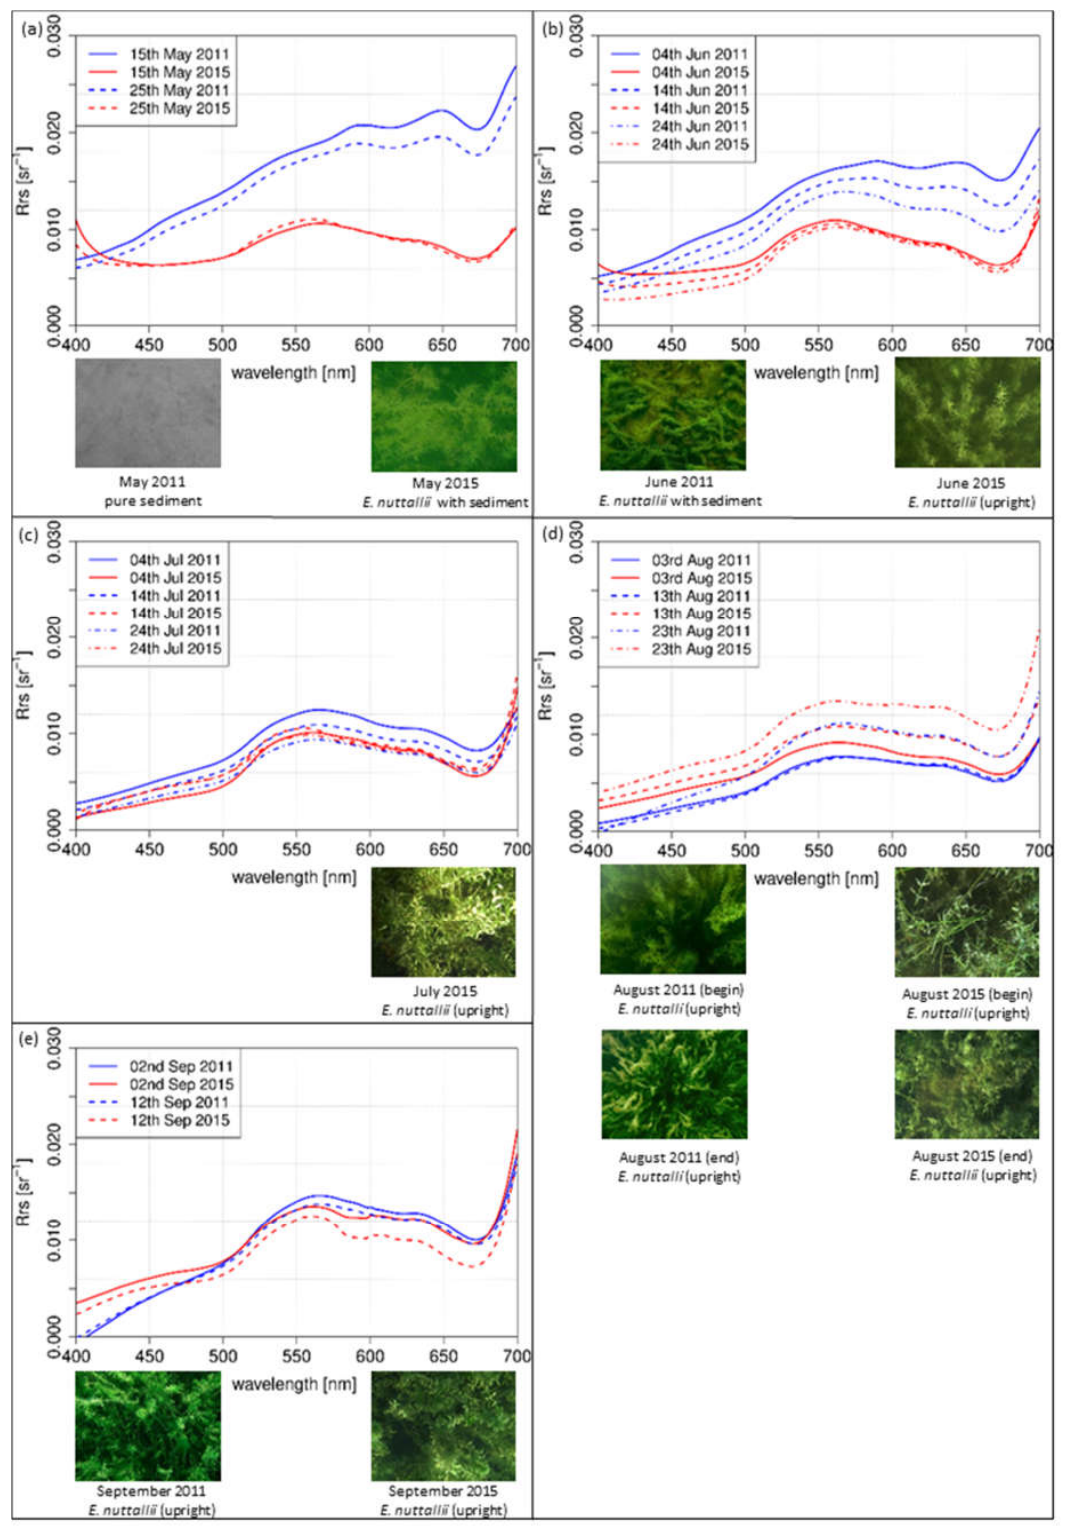
Figure 8. Simulated R rs intensities of E. nuttallii modeled with a linear interpolation method of 2011 (blue) and 2015 (red). Top view photos of the investigated test sites of the sampling days: ( a ) May; ( b ) June; ( c ) July; ( d ) August; and ( e ) September.